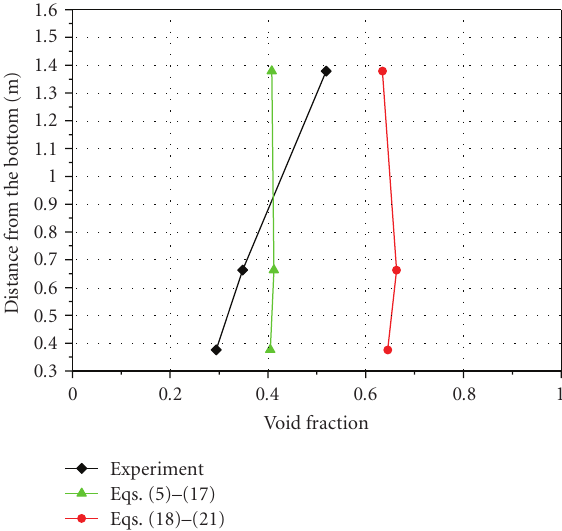
Figure 7: Void fraction profile along height of the right downcomer in the experiment and in the calculations with the use of the models (5)–(17) and (18)–(21). Table 1: Collapsed levels above SPS, m.